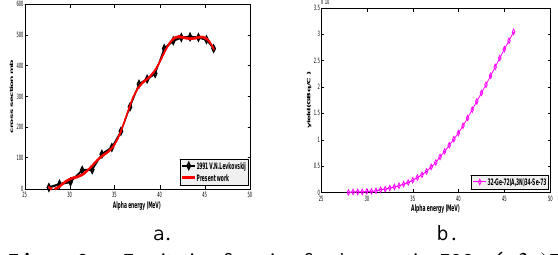
Figure 9: a. Excitation function for the reaction72Ge (α,3n)73Se. b. Isotopes production yield for the reaction 72Ge (α,3n)73Se